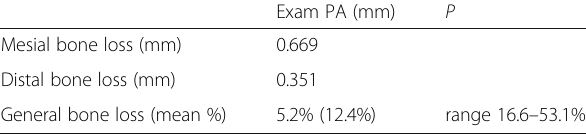
Table 3 Bone loss measured in periapical